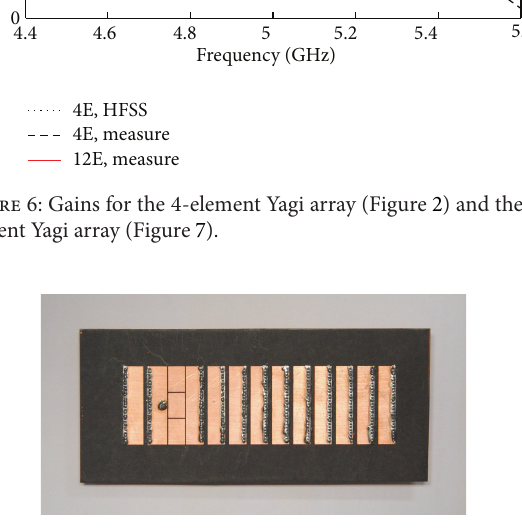
Figure 7: Photo of the 12-element Yagi array of quarter-wave patch antennas.